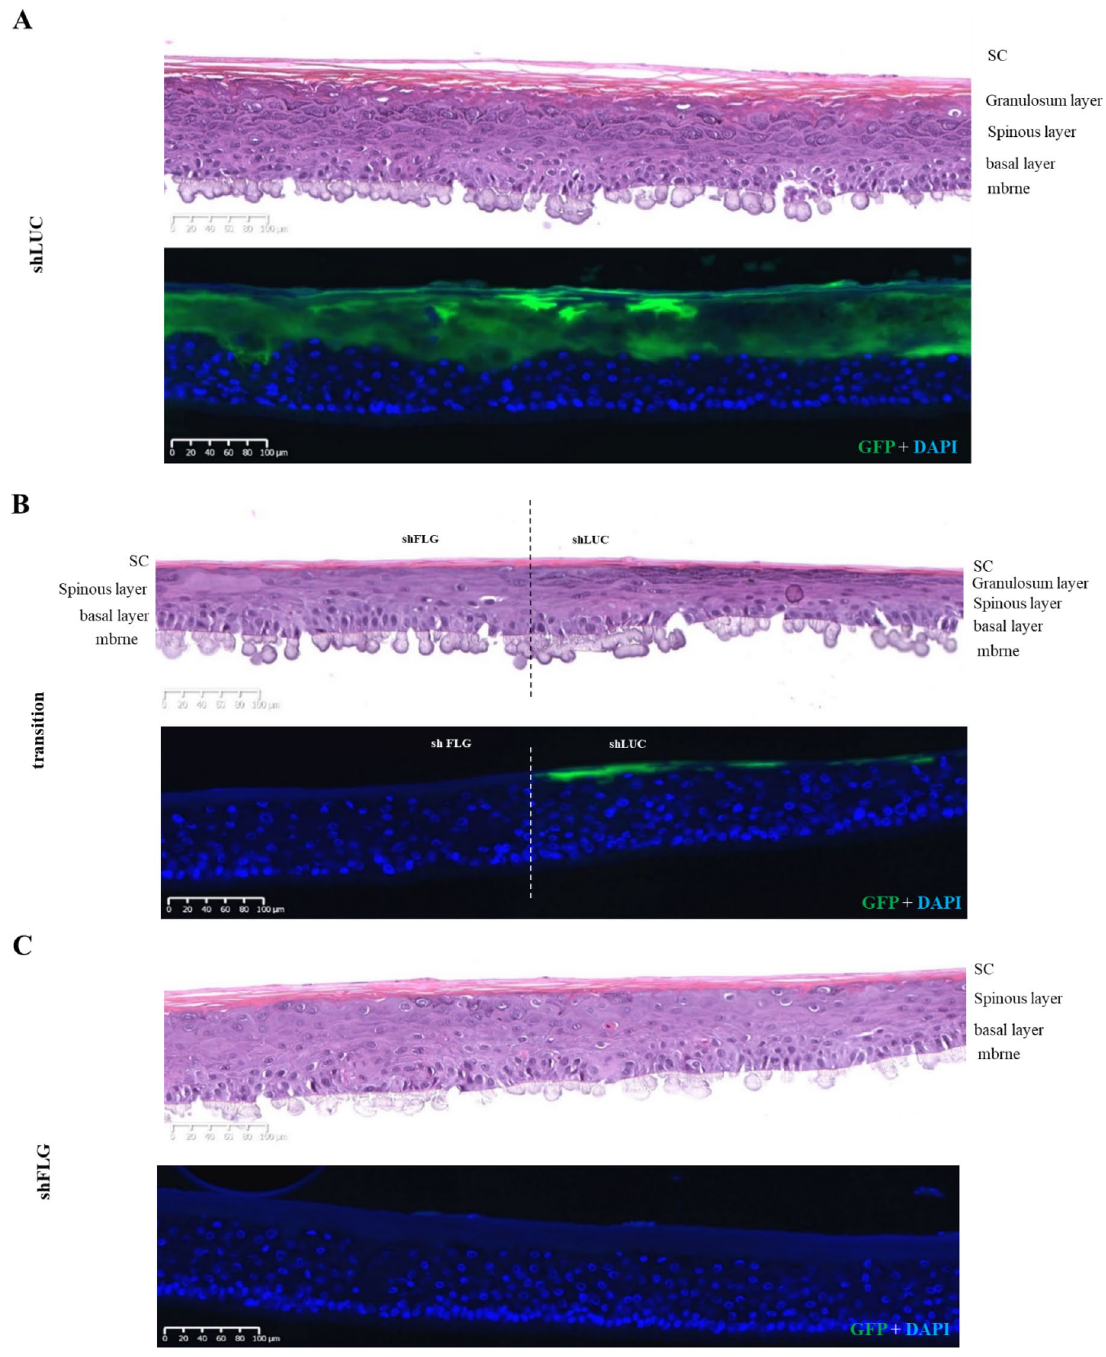
Figure 7. Histological analysis and GFP expression in shLUC and shFLG halves of pattern bioprinted reconstructed skin. ( A ) The suLUC half of the patterned model is histologically normal and shows high levels of GFP staining as anticipated, which abruptly ceases at the border with the shFLG printed half ( B ). ( C ) The shFLG printed half of the model demonstrates a lack of keratohyalin granules in H&E staining and no GFP signal, demonstrating the model to be accurately printed and stable with no migration of cell populations after 14 days in culture. Images representative of 8 individual 5 days, at an initial density of 1.5 × 10 6 cells, in an incubator at 37 °C and in a humidified atmosphere containing 5% of CO 2 , with a medium change every two days. When 3T3 covered 70–80% of the flask area, they were treated with a solution of 0.5 mg/ml of Mitomycin C (Sigma, USA) and Dulbecco’s phosphate-buffered saline enriched with calcium and magnesium (PBS+, ThermoFisher, USA) solution for two hours in a 37 °C/5% CO 2 incubator. Mitomycin C-treated 3T3 were washed with phosphate buffered saline (PBS, ThermoFisher, USA) and harvested at passage 13 using 0.05% Trypsin EDTA (1×) (Gibco, USA), resuspended in DMSO (Sigma, USA) 7.5% diluted